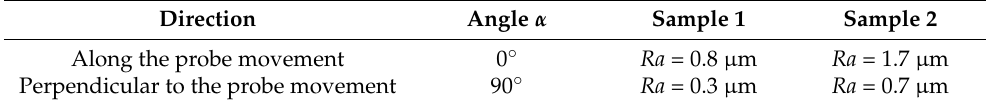
Table 1. Roughness of the sample surfaces in the two directions of measurement. Direction Angle α Sample 1 Sample 2 Along the probe movement